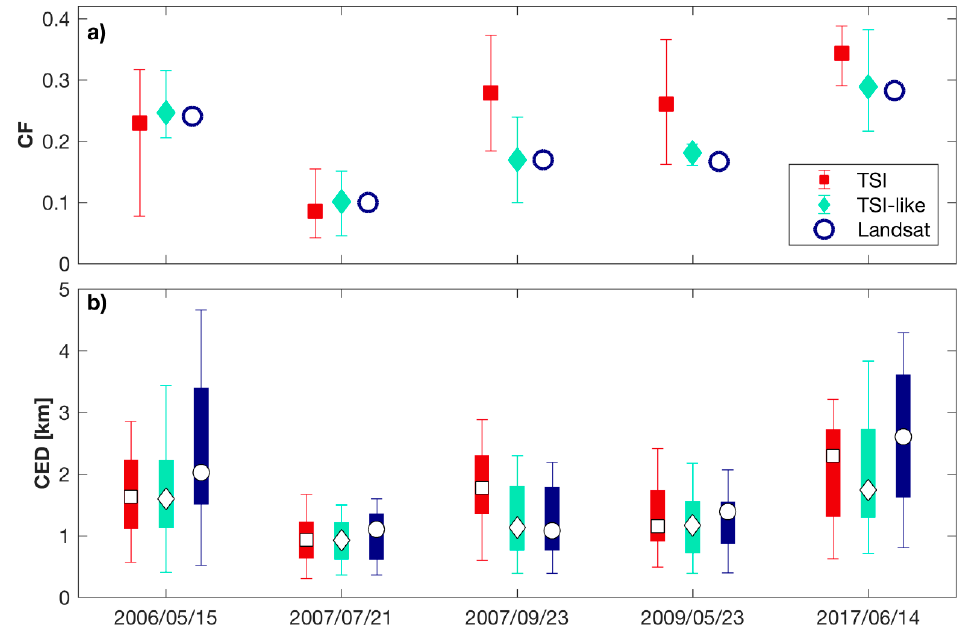
Figure 5. ( a ) 1-h averaged cloud fraction for TSI (red square), TSI-like sampling (green diamond) and within the Landsat subarea (navy circle). Error bars show the minimum and maximum 15-min average for TSI and TSI-like. ( b ) Percentiles of cloud cover density summarize population CED. Open symbols are the median ( L 50 ) for TSI (square, red), TSI-like (diamond, green) and Landsat (circle, navy) with 25th and 75th (box) and 5th and 95th (whiskers) percentiles.